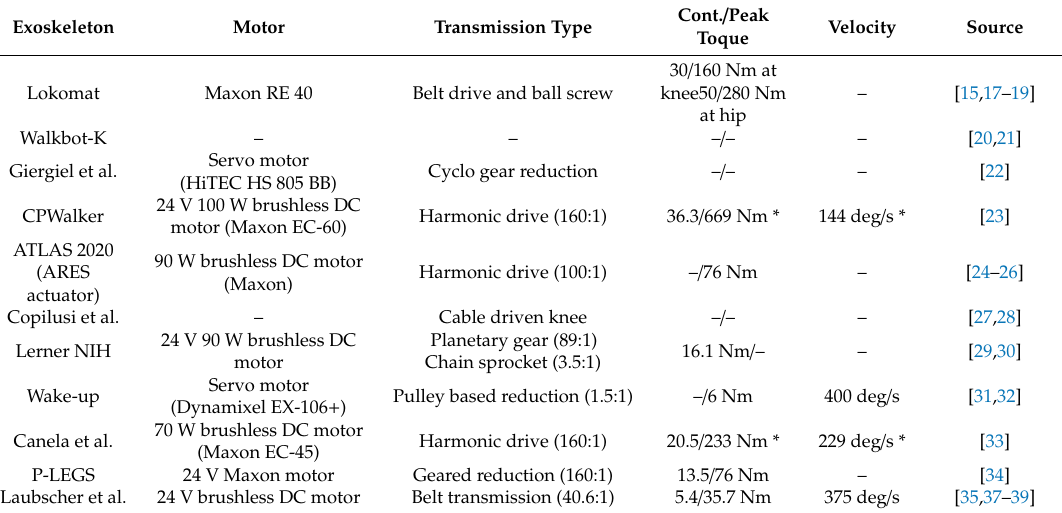
Table 2. Summary of reported information on existing actuators for pediatric